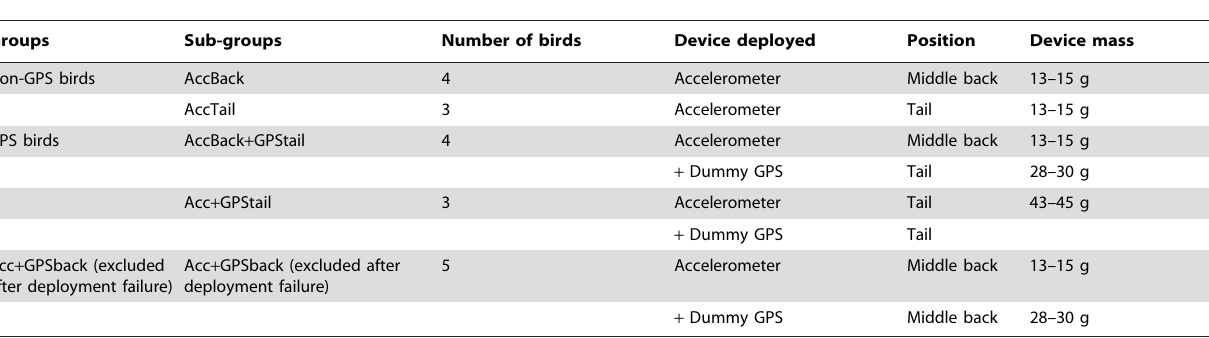
Table 1. Details of the device deployment conducted on northern gannets ( Sula bassana ).